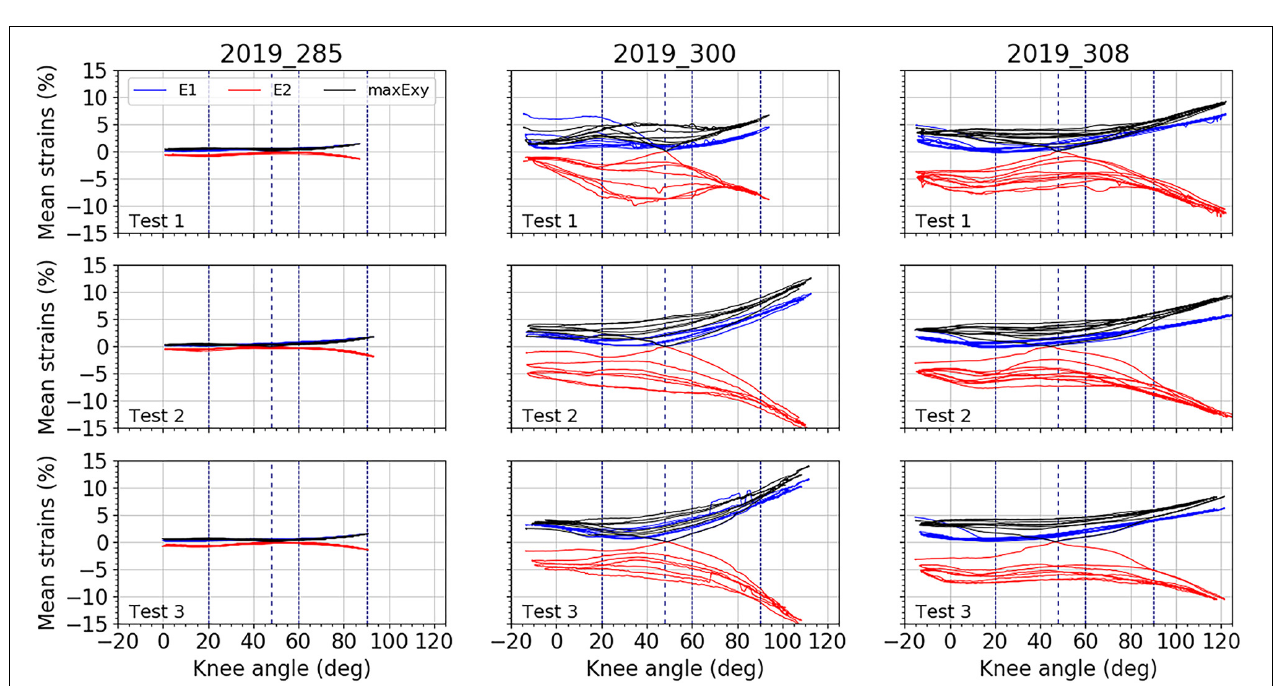
FIGURE 6 | Mean strain distributions over the knee angles for the lateral fascia. In blue, mean major principal strain E 1 , in red, minor principal strain E 2 , and in black maximal shear strain maxE xy . For each test, all cycles are plotted. Vertical dashed line represents the knee position chosen as reference: 47 ◦ . Three other vertical lines locate knee angles of 20 ◦ , 60 ◦ , and 90 ◦